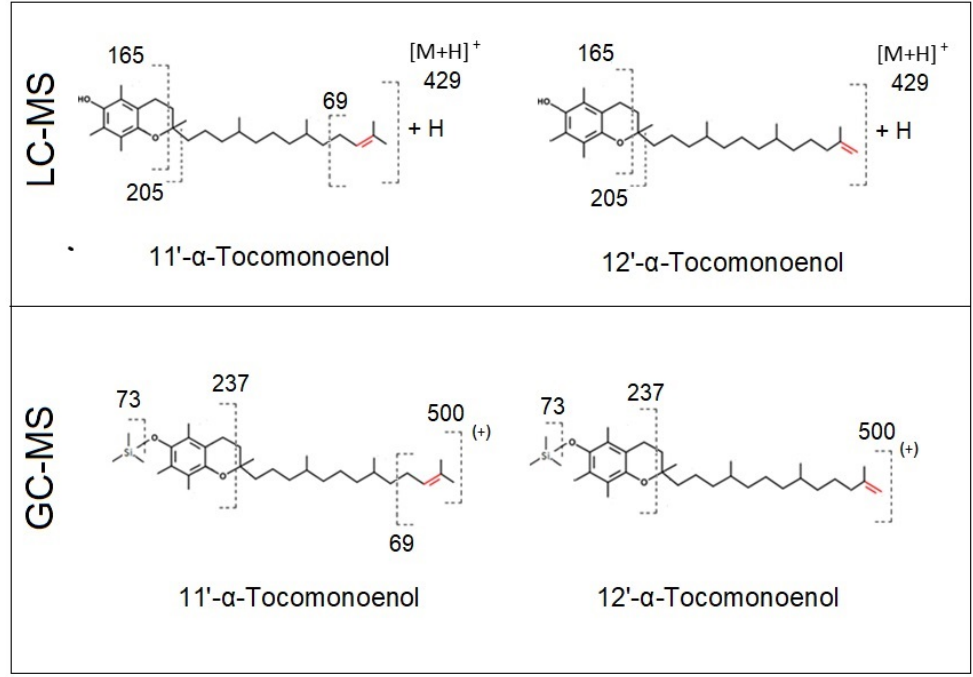
Figure 2. Expected fragmentation patterns of 11 ′ - α -tocomonoenol (11 ′ - α T1) and 12 ′ - α -tocomonoenol (12 ′ - α T1) using LC-MS (upper panel) [40,41] and GC-MS after silylation (lower panel) [29,41]. Table 1. Fragmentation patterns for targeted analysis of α -tocomonoenols ( α T1) in Chlorella sorokin- iana , Nannochloropsis limnetica , and Tetraselmis suecica using LC-MS n . RT Sample Identified Ions (min)